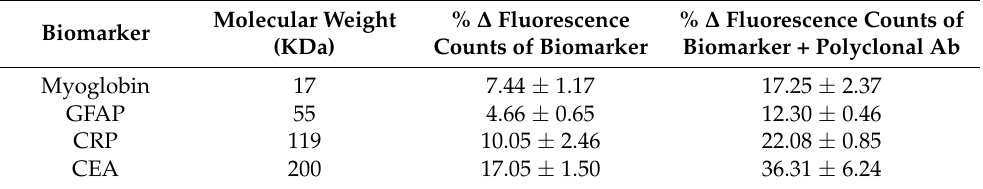
Table 1. Showing the percentage quench in fluorescence intensity of the chelated Eu 3+ to